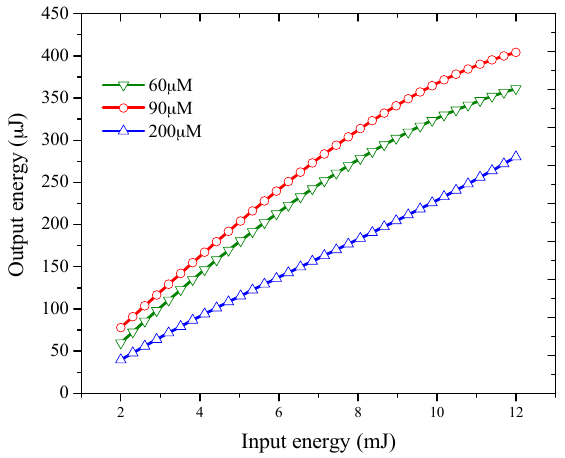
Figure 8. Efficiency of ASE with input energy (mJ) verses output energy ( μ J).